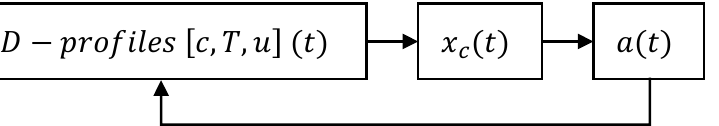
Figure 18. Scheme of the phenomenological relationships between 2D profiles, coking and catalyst activity.